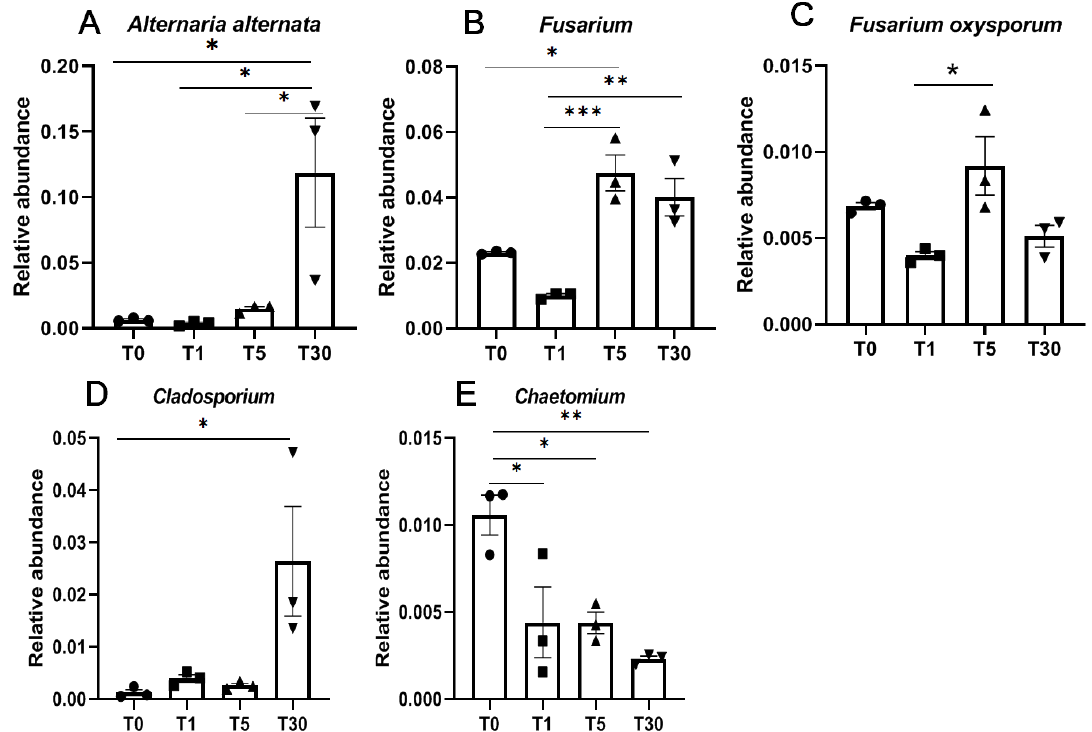
Figure 6. Relative abundance of beneficial and pathogenic fungi. ( A , C ) Pathogenic fungi species; ( B , D ) pathogenic fungi genera; ( E ), beneficial fungus. Significance between di ff erent groups were compared using a one-way ANOVA test, with the results indicated on the top ( p -value ≤ 0.05 = *, p -value ≤ 0.01 = **, and p -value ≤ 0.001 = ***).